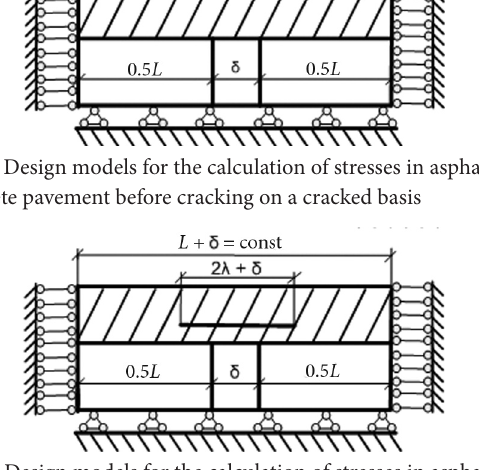
Fig. 3. Design models for the calculation of stresses in asphalt concrete pavement before cracking on a cracked basis with a crack-interrupting layer